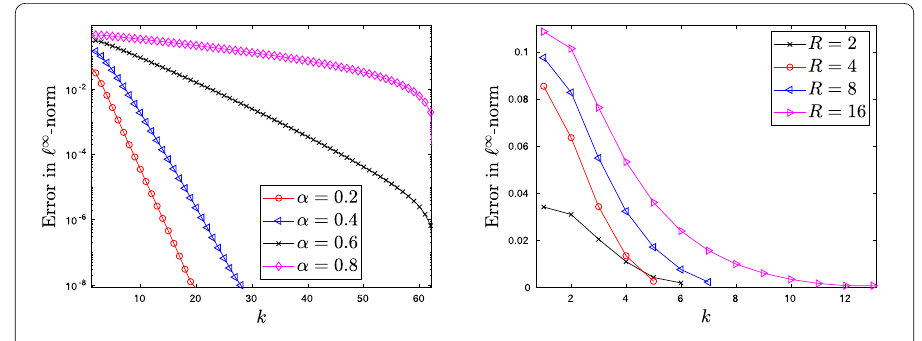
(cid:14) 2 as function of k with (Left) R = 4, (cid:2) T = 2 T